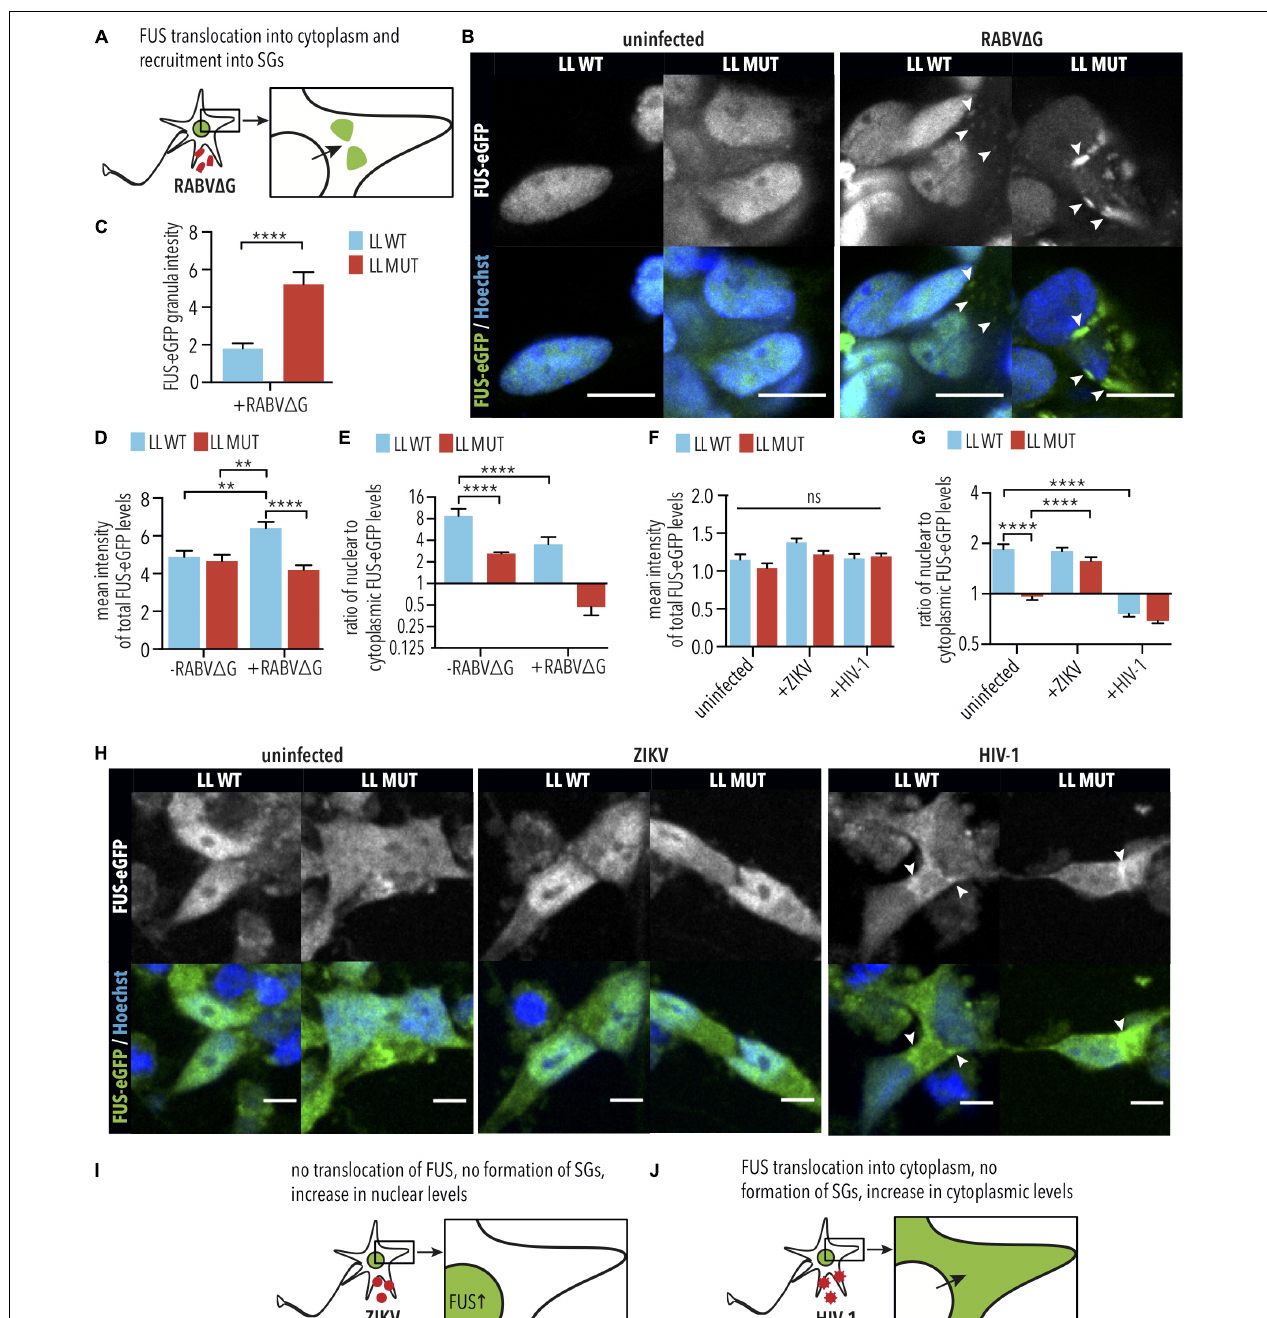
FIGURE 5 | RABV (cid:49) G and HIV-1 induce FUS-eGFP nuclear to cytoplasmic translocation. (A) Schematic view of changes in FUS-eGFP during RABV (cid:49) G infection. (B) FUS-P525L spinal neurons show increased translocation of FUS-eGFP from the nucleus to the cytoplasm as well as recruitment to SGs. Mean FUS-eGFP intensity was measured from confocal images. White arrows indicate SGs. Scale bar = 10 µ m. (C) FUS-eGFP levels in RABV (cid:49) G-induced granules are increased in FUS-P525L neurons in comparison to WT. ∗∗∗∗ indicate p < 0.0001, according to 2-tailed unpaired t- test. Error bars represent SEM. n = 3. (D) FUS-WT spinal neurons infected with RABV (cid:49) G show increased total FUS-eGFP mean intensity levels. ∗∗ and ∗∗∗∗ indicate p < 0.01 and 0.0001, respectively. n = 3. (E) FUS-eGFP is mislocalized following RABV (cid:49) G infection of spinal neurons. Predominant localization of FUS-eGFP is nuclear if ratio > 1, cytoplasmic (mislocalized) if ratio < 1. ∗∗∗∗ indicates p < 0.0001. Error bars represent SEM. (F) Total FUS-eGFP levels were unaffected by HIV-1 and ZIKV infection. ns, Not significant. n = 6. (G) FUS-eGFP is mislocalized in FUS-P525L and WT HIV-1 infected spinal neurons. ∗∗∗∗ indicates p < 0.0001 according to one-way ANOVA, Tukey post-test for multiple comparisons. Error bars represent SEM. (H) FUS-P525L and FUS-WT spinal neurons show increased translocation of FUS-eGFP out of the nucleus, into the cytoplasm after HIV-1 infection. White arrows indicate increased FUS-eGFP levels at nuclear periphery. Scale bar = 10 µ m. (I,J) Schematic view of changes of FUS-eGFP during ZIKV and HIV-1 infection. LL indicates long linker; MUT, mutant; WT, wild type; vRNA, viral RNA; SG, stress granules.